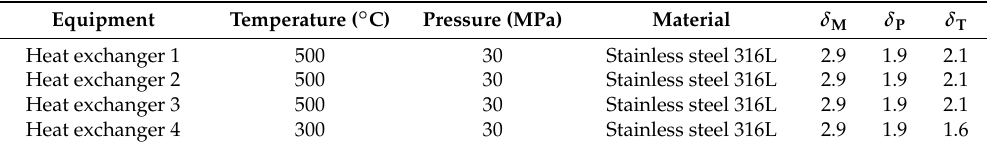
Table 5. The coefficients for heat